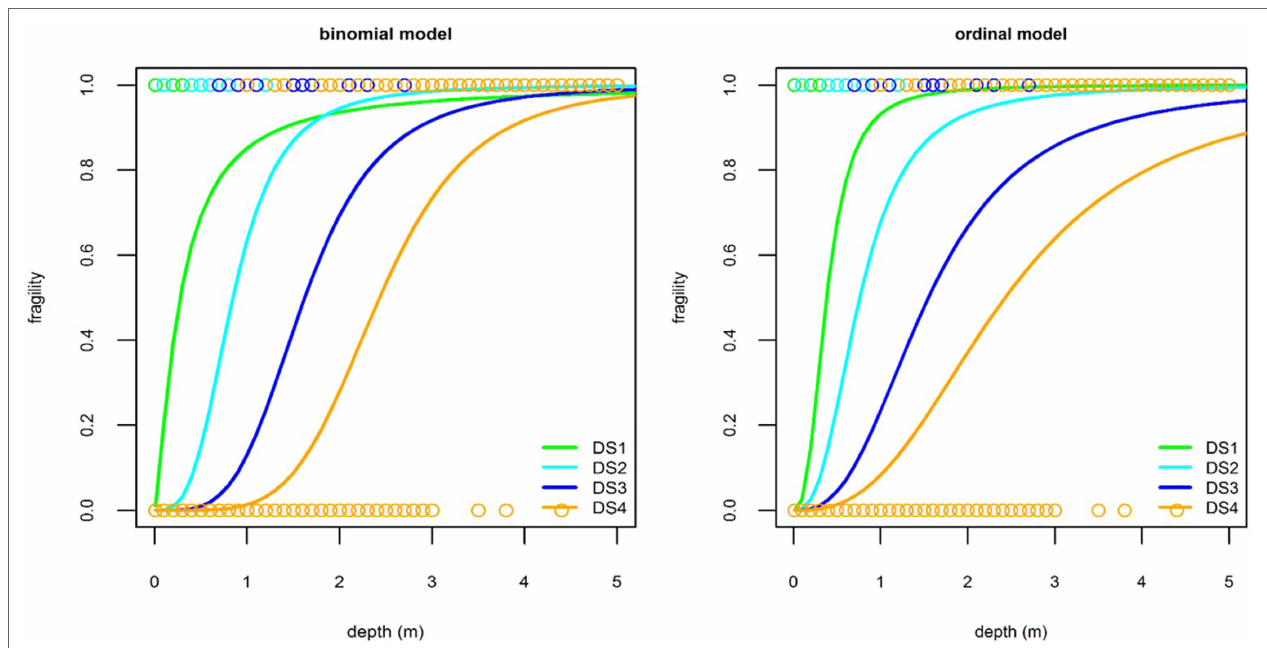
FIGURE 4 | Left —Crossing Fragility Functions—An unrealistic result which can be rectified by using ordinal regression. Here, the binomial logistic model has been fitted to a representative sub-sample of the data used in Charvet et al. (2014b) for illustrative purposes. Right —The same data analyzed using ordinal regression. The cross-over cannot take place.